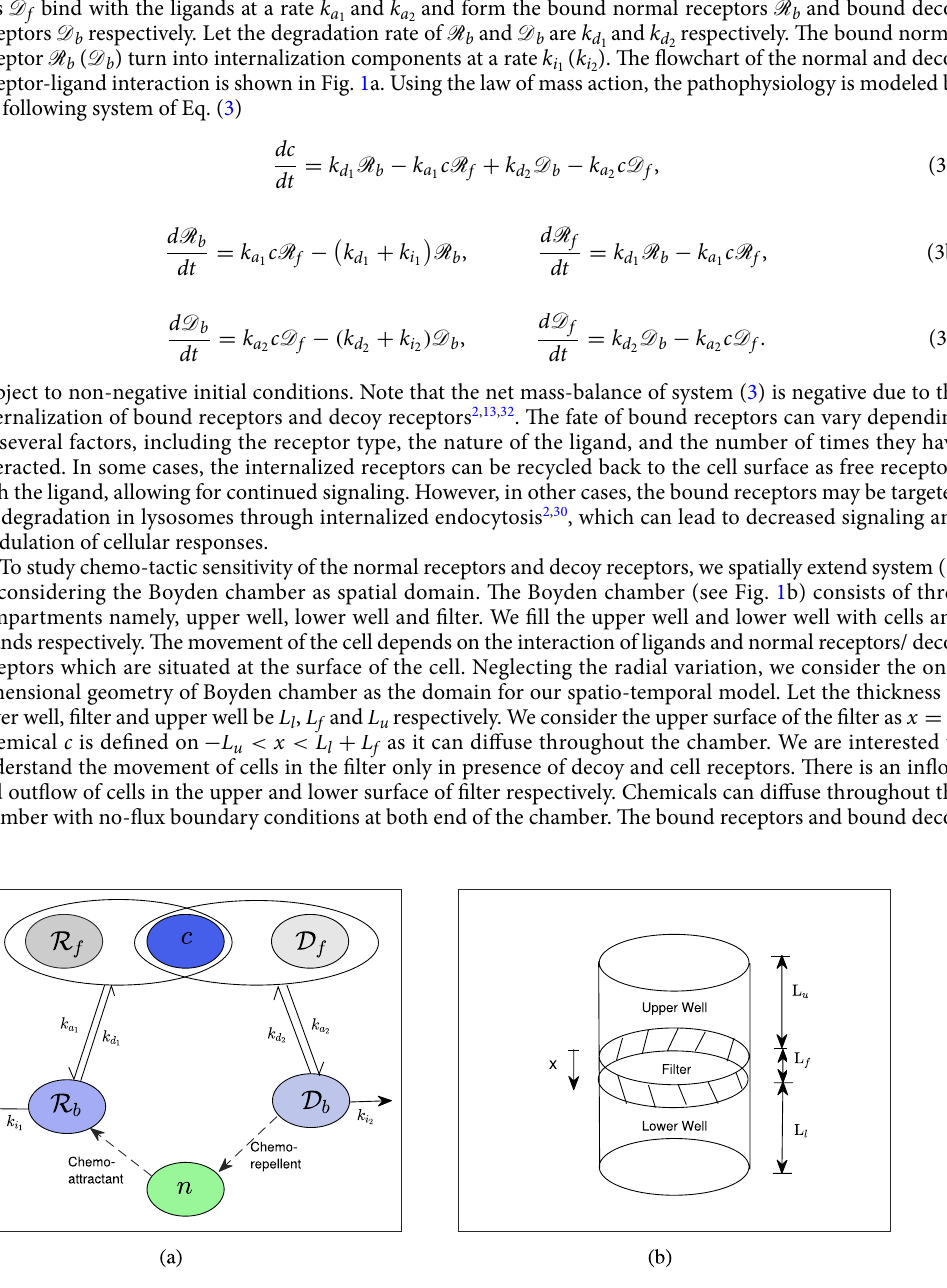
Figure 1. ( a ) Schematic presentation of cell migration in response to receptor-ligand interaction. Solid arrow indicates the conversion of the same variable according to the system (3) and dashed arrow represents the chemo-tactic sensitivity of the bound receptors. ( b ) Schematic representation of the Boyden chamber. A filter separates the chamber into two wells. The upper well and lower well are filled with cells and chemicals or ligands respectively. In response to chemo-tactic sensitivity, cells settle onto the filter and migrate through